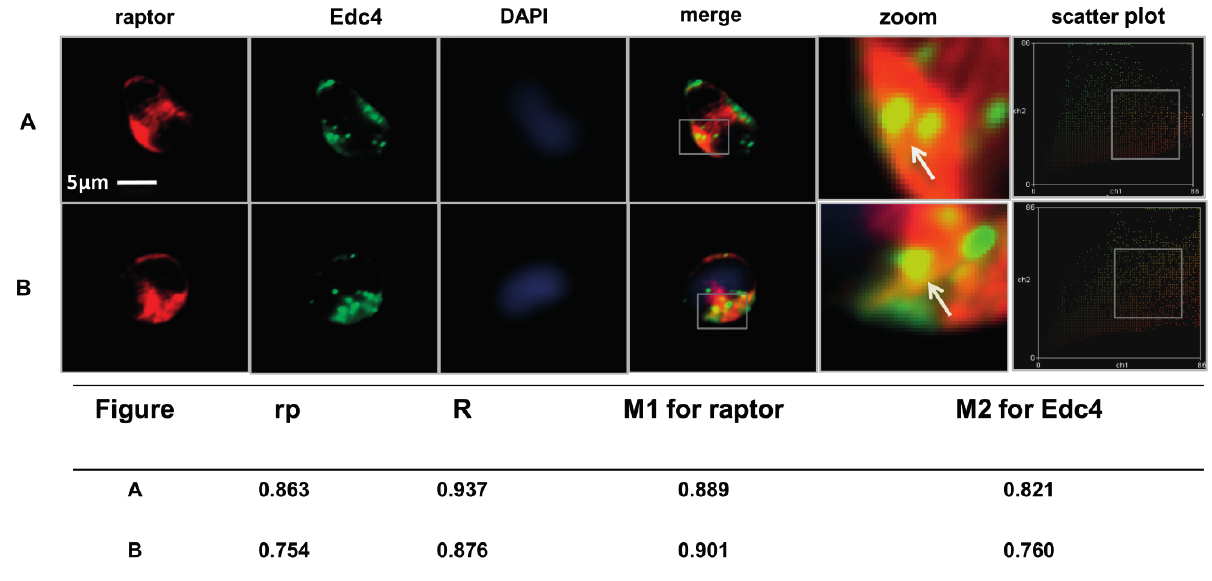
Figure 3. Edc4 co-localization with raptor component of mTORC1: CCRF-CEM cells were grown, fixed, permeabilized and both rabbit anti-Edc4 and mouse anti-raptor were added and incubated overnight. Fluorescent signals were detected using labeled anti-mouse Cydye3 and anti-rabbit Alexa Fluor 488. Raptor and Edc4 co-localization in CCRF-CEM cells was analyzed using an Axiovert 200M confocal microscope and processed with Image J software. The yellow overlay images demonstrate the high co-localization of raptor (red) with Edc4 (green) in processing bodies (P bodies, arrows indicate P bodies). The scatter plot of the individual pixels was obtained from two source images . Quantitative co-localization analysis illustrates increased co-localized pixels of Edc4 with raptor. At least 30 cells were observed per experiment (Scale bars = 5 μ m) and experiments were repeated five times (only two experimental replicates A and B are shown). DAPI (4,6-diamidino-2-phenylindole) blue colour indicates cell